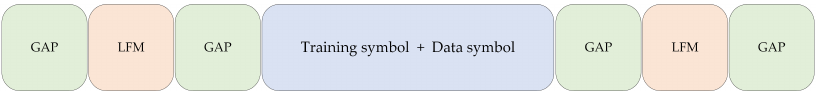
Figure 14. Design of transmitting signal structure.